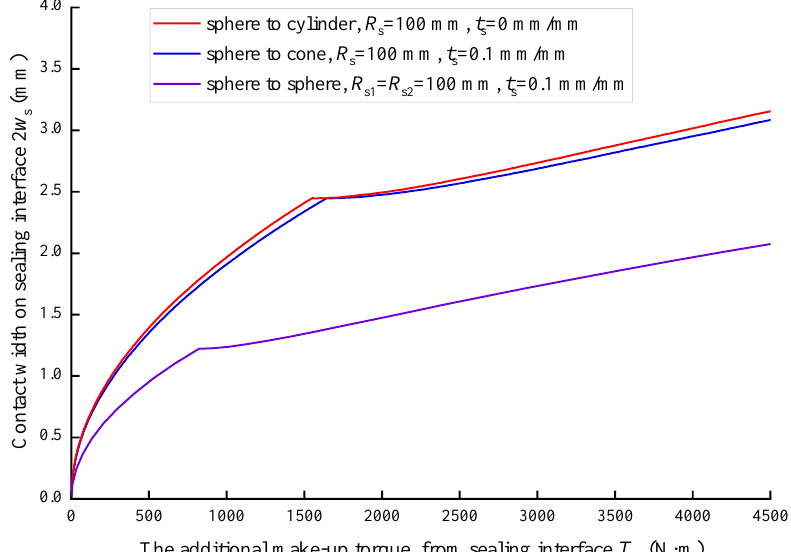
Figure 8. Effects of additional make-up torque from sealing interface on contact width on sealing interface for three kinds of sphere-type premium connections.